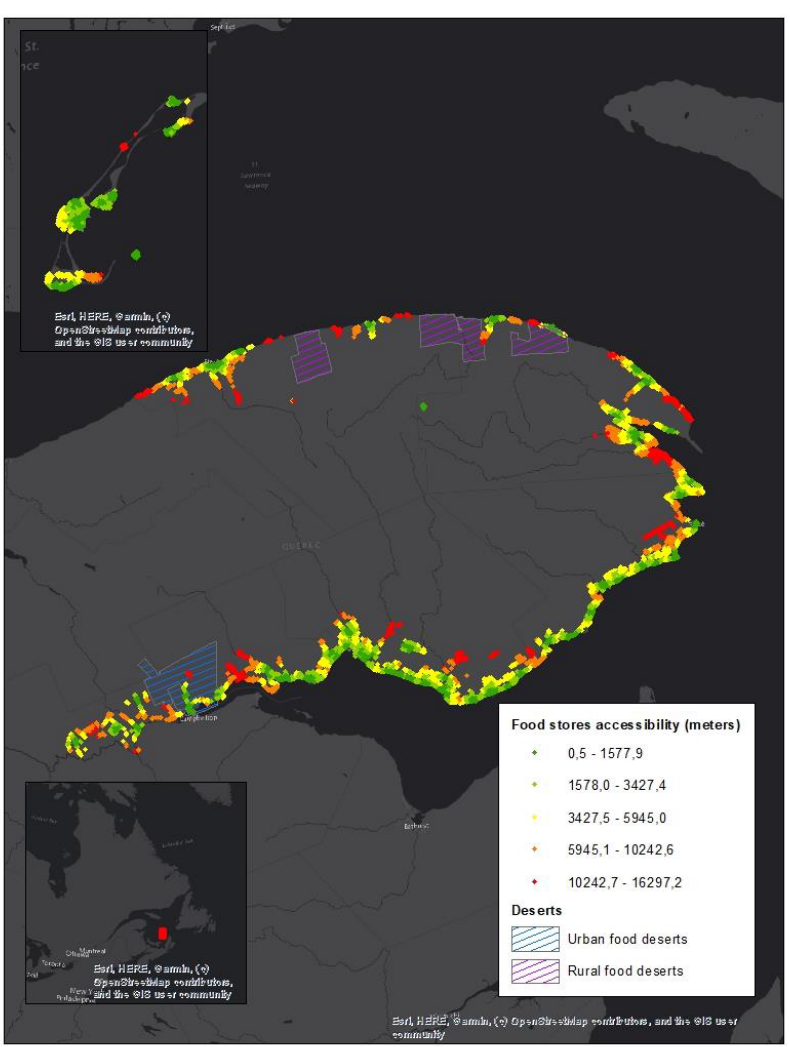
Figure 3. Food desert localization. Table 2. Average level of the RFEI and number of sectors qualified as food swamps by disadvantage quintiles of RFEI # of sectors in rural areas # of sectors in urban areas. Quintiles of Disadvantage Mean Level of # of Sectors in Average Level RFEI Rural